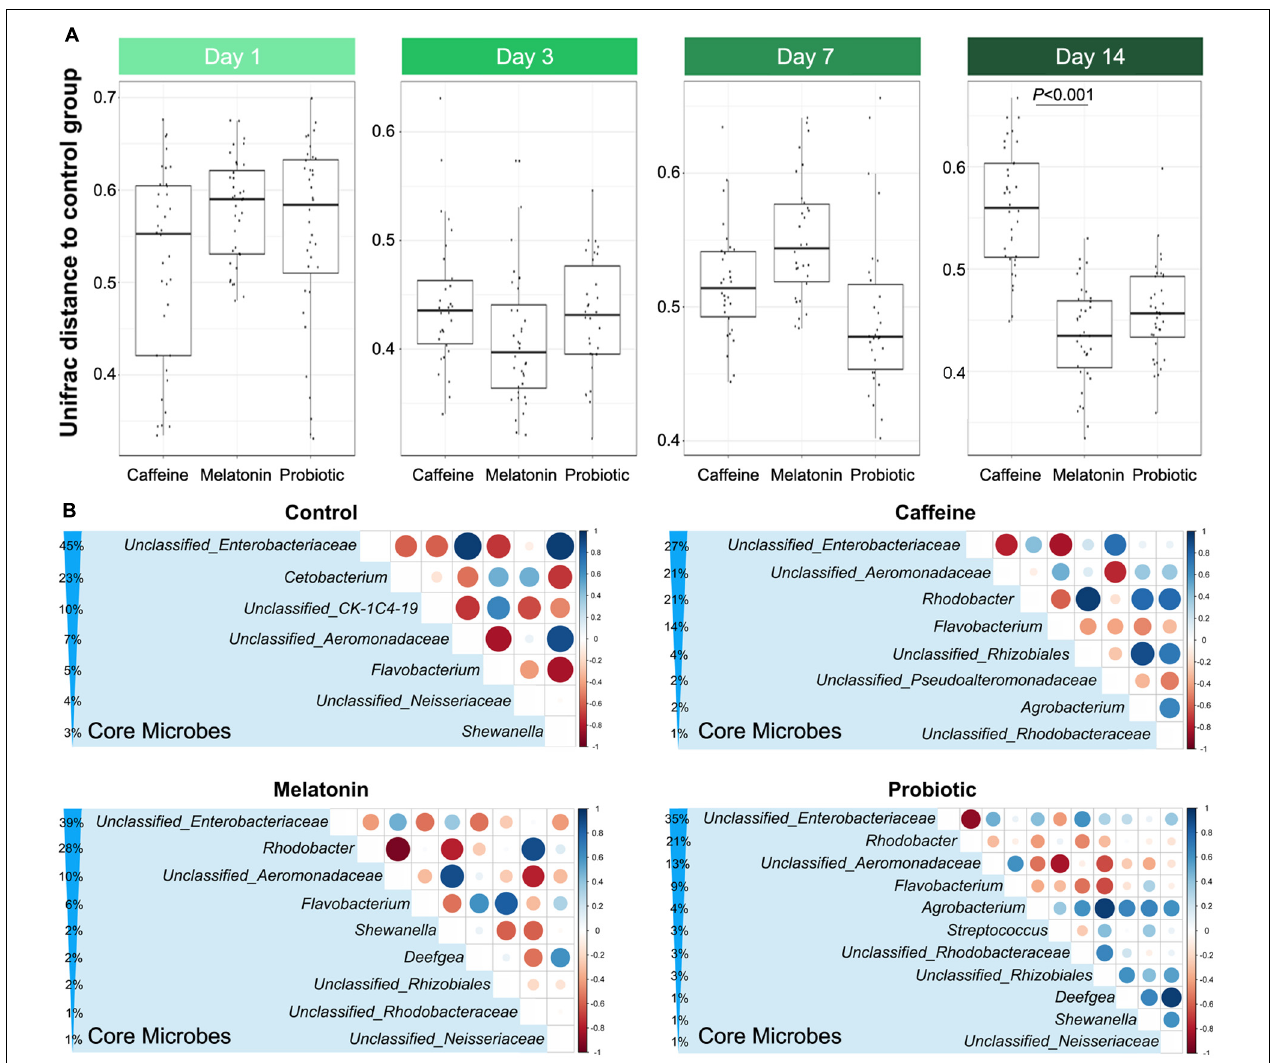
FIGURE 2 | Comparison of similarities and core genera between groups. (A) The distance based on the unweighted UniFrac between the control and three different treatment groups displays the difference of the gut microbiota among different groups on days 1, 3, 7, and 14, which include control vs. caffeine, control vs. melatonin, and control vs. probiotic. (B) Comparative analysis of core genera accounting for more than 1% in the control, caffeine, melatonin, and probiotic groups after 14 days of corresponding treatment. The percentage indicates the relative abundance of the corresponding genus. The size and color of the circle are proportional to the correlation intensity. The redder the color, the stronger the negative correlation, and the bluer the color, the stronger the positive correlation.